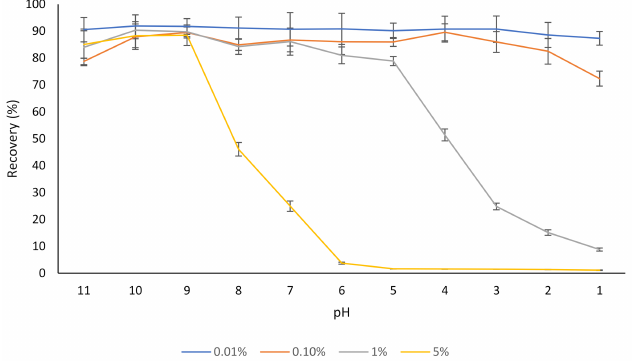
Figure 1. The effect of pH on the aqueous solubility (recovery) of different concentrations of rutin (0.01–5%). The results are means of three replicates of